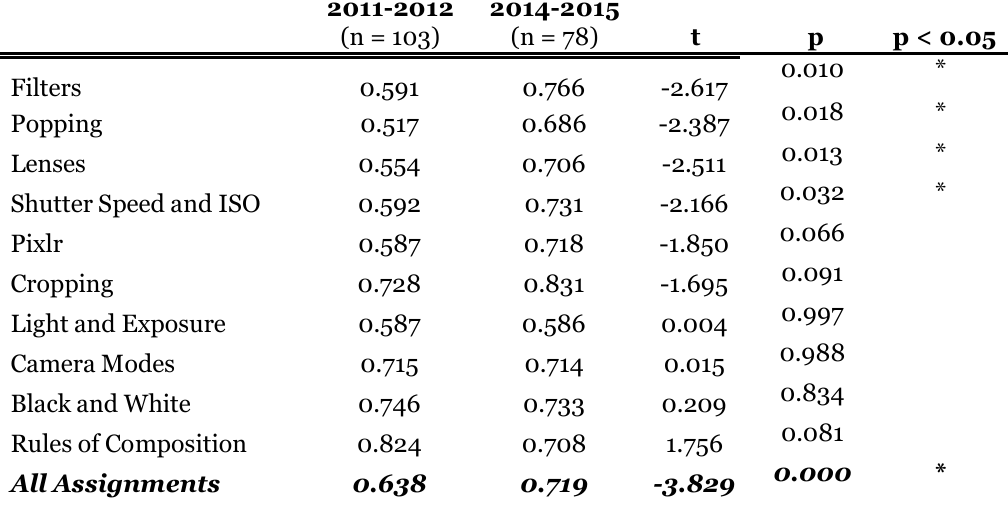
Table 1 Average Assignment Grades and T Test